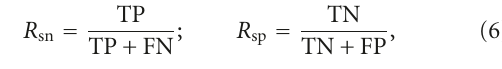
respective spectrum of interest at a particular time and the parameter from second conditional moment corresponds to the variance var( t ). It is worth mentioning that the f c ( t ) and var( t ) represent, respectively, the instantaneous frequency (IF) and the instantaneous bandwidth (IB) for the case of TFDs whose kernel satisfies the IF property [20].